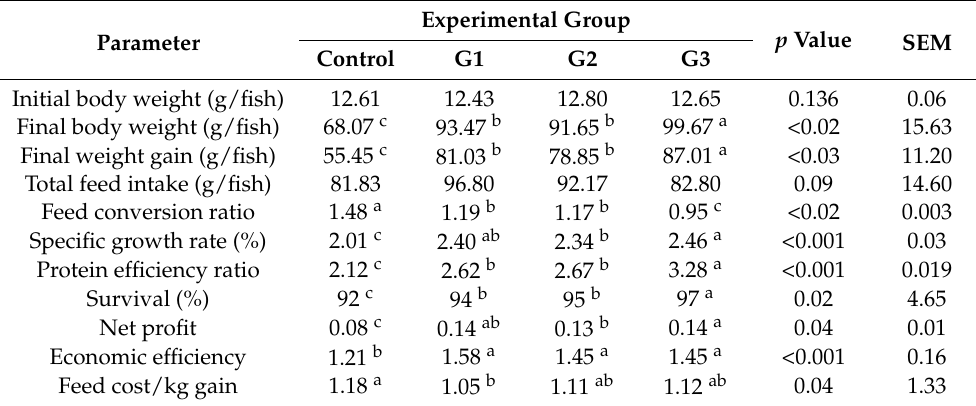
Table 3. Growth performance and profitability variables of Nile tilapia ( O. niloticus ) fed diets fortified with Thy and/or ThQ.